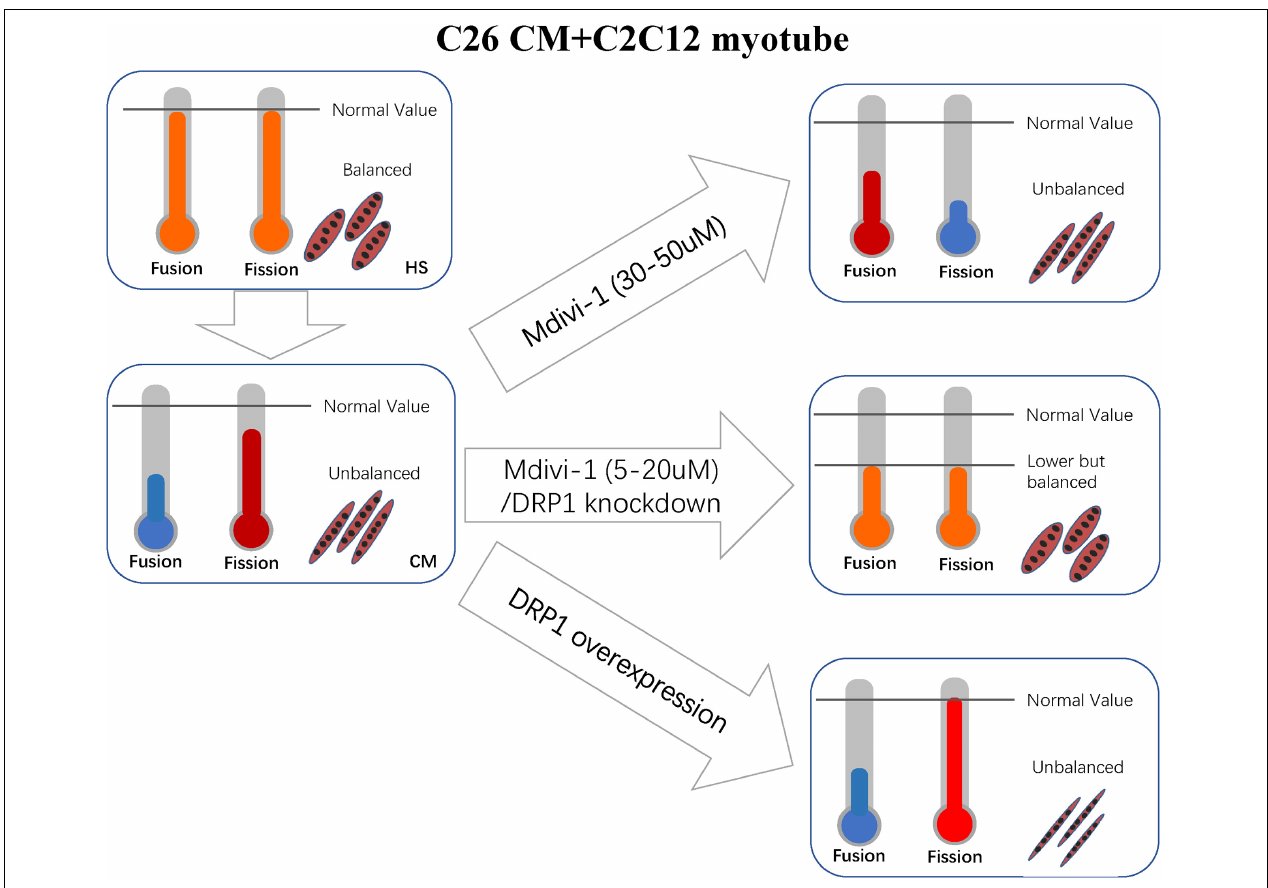
FIGURE 7 | Correlated machinery elucidated in section